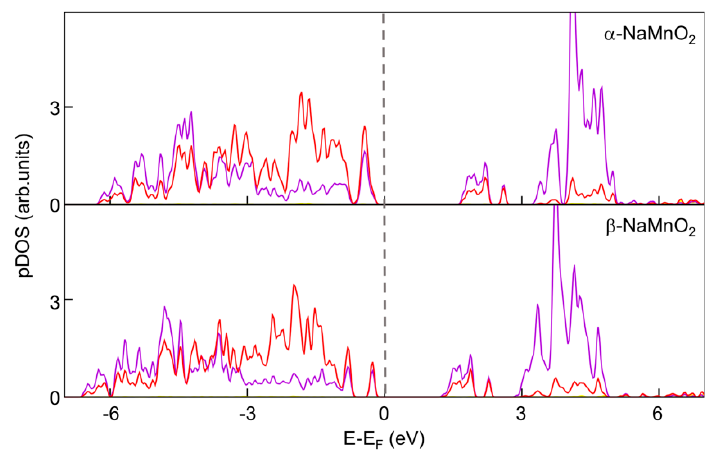
Figure 5. Atom- and angular momentum- projected density of states (pDOS) computed for α - NaMnO 2 ( top ) and β -NaMnO 2 ( bottom ) at PBE+U-D3BJ level of theory. Color code: Mn d (purple), O p (red).